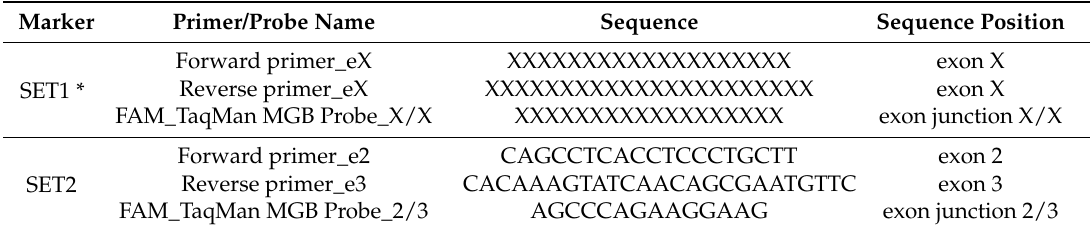
Table 1. Primers and probes used for